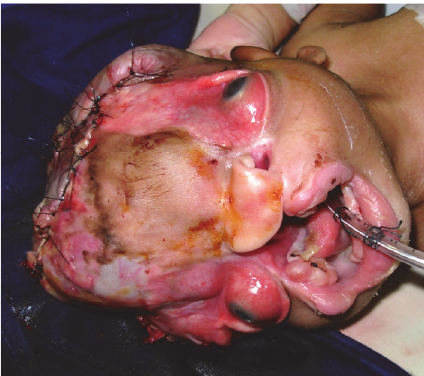
Figure 1: After surgical